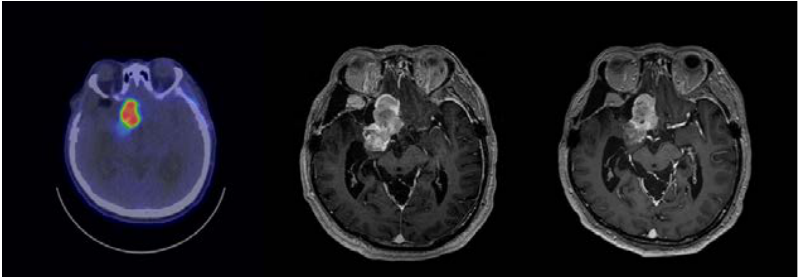
Figure 5. Images of case 284 with recurrent spheno-cavernous atypical meningioma. ( Left ) Pre-BNCT, Fluciclovine-PET image, with tumor-to-normal tissue (TN) ratio around 7.07. ( Middle ) Pre-BNCT, axial MRI with contrast. ( Right ) Post-BNCT, axial MRI with contrast two months after BNCT.